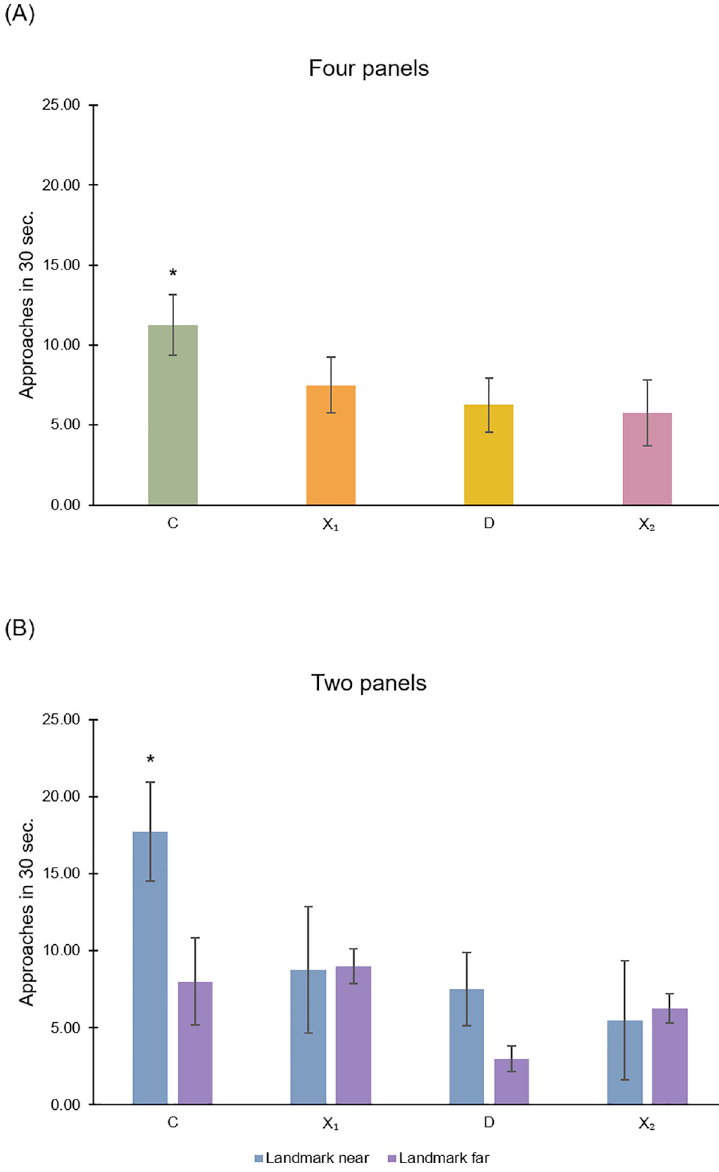
Fig 5. Total approaches in Experiment 1: Rectangular apparatus with panels in the spontaneous memory task. (A): Mean (SD) number of approaches at the four corners in 30 seconds of test, under a working memory procedure, in the experimental condition with four colored panels at corners in rectangular apparatus. (B): Mean (SD) number of approaches in 30 seconds of test in the experimental conditions with two colored panels at corners C-D (landmark near the correct corner) and X1-X2 (landmark far from the correct corner). The asterisk ( � ) indicates a statistically significant difference (p < 0.05). choices between corners C and D (t = 5.591, P = 0.011, 95% CI [0.143, 0.52]), C and X1 (t (3) (3) = 6.789, P = 0.007, 95% CI [0.144, 0.398]), C and X2 (t = 7.833, P = 0.004, 95% CI [0.186, (3) 0.439]) (Fig 4A). Similar results were obtained when considering the overall number of approaches in the 30 seconds of free exploration’s test (Fig 5A): the significant main effect of Corners with ANOVA (F(3,9) = 6.732, P = 0.011, η 2 = 0.692); significant differences in p choices between the correct corner C and D (t = 3.873, P = 0.03, 95% CI [0.891, 9.108), C (3)